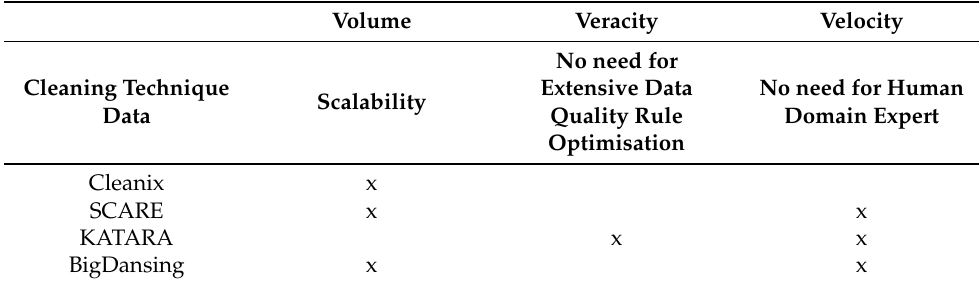
Table 2. Currently used data-cleaning